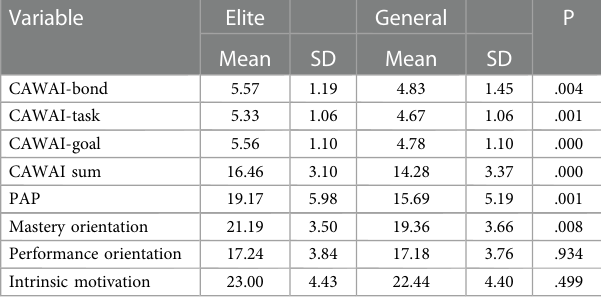
TABLE 4 Independent samples t -test with mean, standard deviation and p -values for the elite group of athletes ( n =58) and general groups ( n =55) within cross-country skiing at high school.